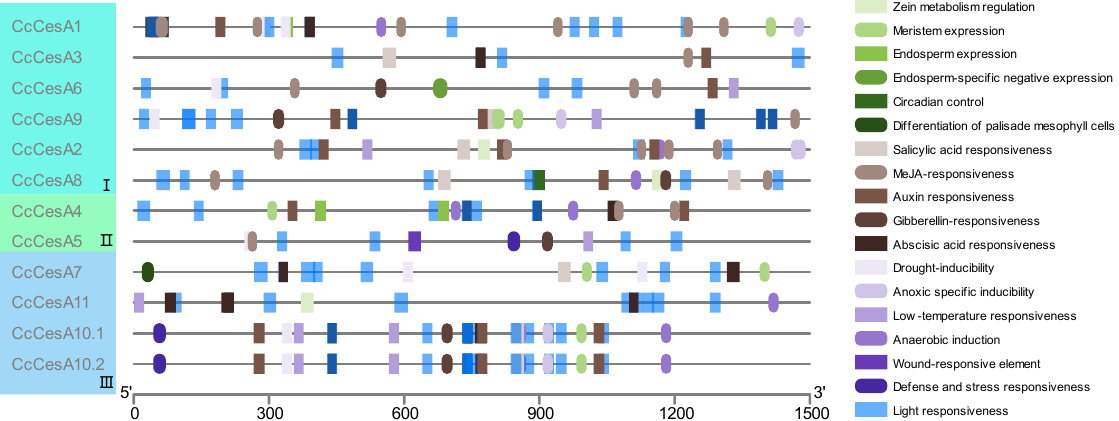
Figure 7. Prediction of cis-responsive elements in the 1500 bp upstream regulatory regions of the putative CcCesA genes. Cis-elements involved in regulating plant growth and development, phytohormone response, stress response, and light response are represented by different shades of green, brown, purple, and blue, respectively.